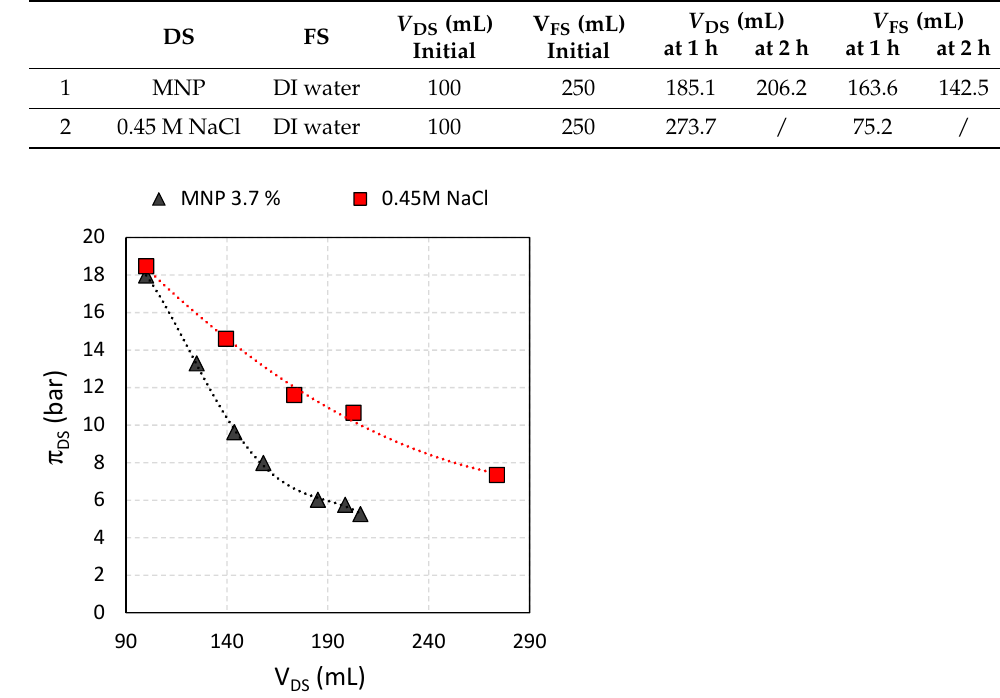
Figure 8. Water fluxes versus filtration time. Higher initial flux was reached using 0.45 M NaCl solution (14.1 LMH) when compared to Fe 3 O 4 @CA (9.3 LMH), respectively. Table 5. The initial and final volumes of the DS and FS.